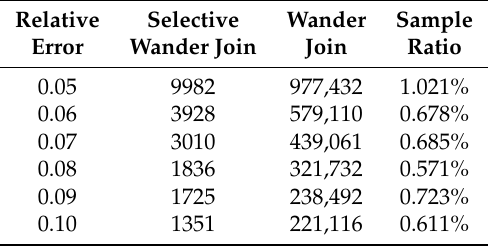
Table 1. The number of samples needed by Selective Wander Join and Wander Join for all groups to achieve the same relative error rate for the flights GROUP BY